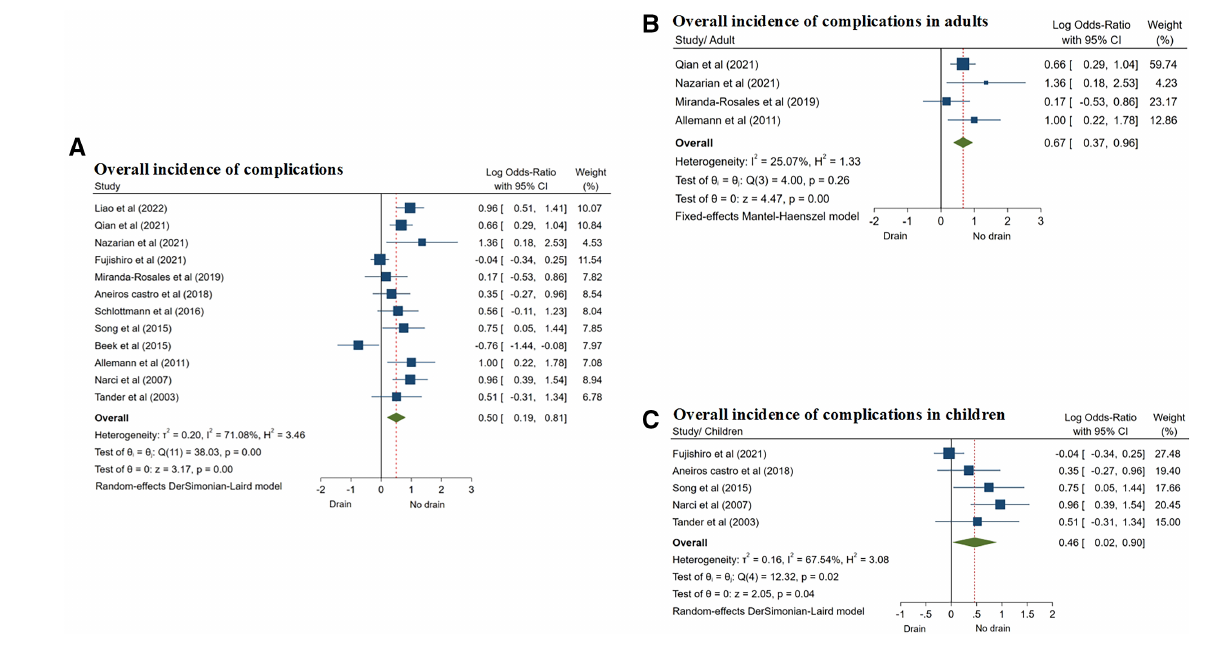
FIGURE 4 Forest plots of meta-analysis and subgroup meta-analysis comparing morbidity, ( A ) overall incidence of complications; ( B ) overall incidence of complications in adults; ( C ) overall incidence of complications in